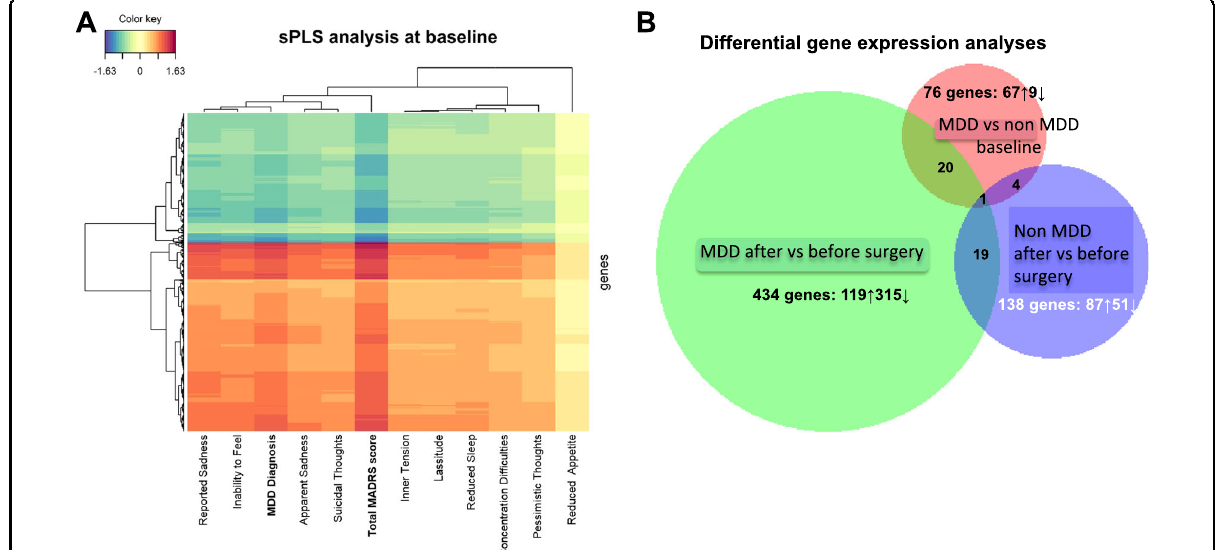
Fig. 1 Gene expression analyses at baseline and after bariatric surgery in MDD and non-depressed patients. A Heatmap of the results of the sparse least square analysis (sPLS) on the 33 patients at baseline showing the strength of correlation between the 2000 gene probes the most correlated to depression (color code at the top left); each line corresponds to a gene probe and in each column a phenotypic value of depression. B Venn diagrams of the three differential expression analyses showing signi fi cantly differentially expressed genes.